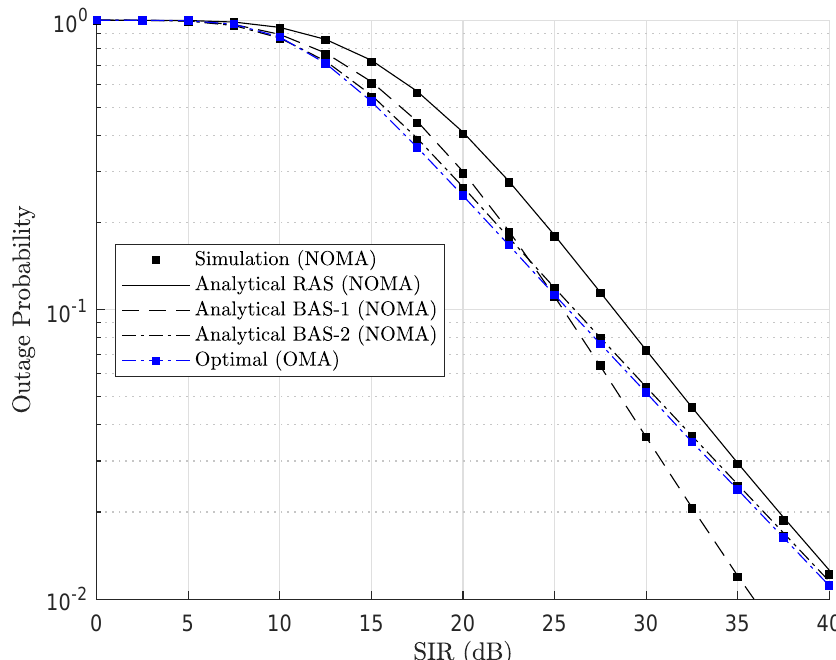
Figure 3. Outage performance of the proposed system, in which d 1 = 200 m, d 2 = 100 m, ¯ R 1 = 1 (bps/Hz) and ¯ R 2 = 3